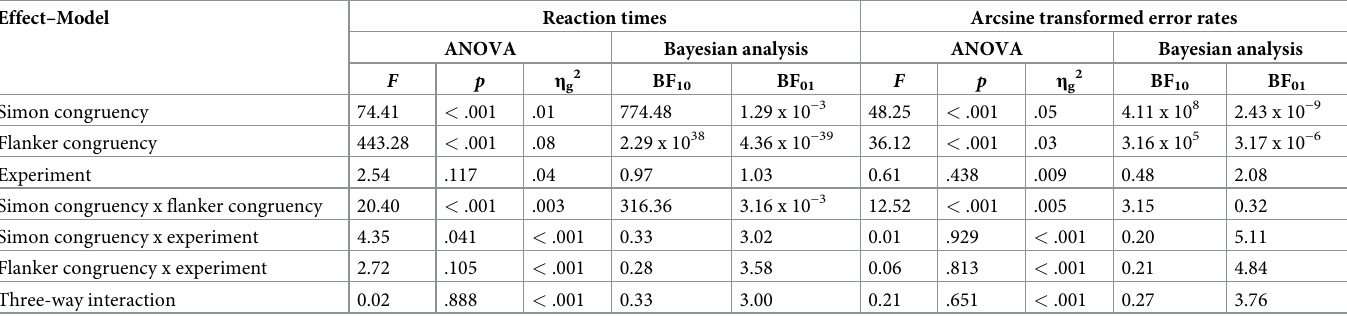
Table 6. Experiment 2 (Simon horizontal–flanker vertical) vs. Experiment 3: Inferential statistical values for the three-way analysis of variance (ANOVA) with Simon congruency (incongruent, congruent) and flanker congruency (incongruent, congruent) as within-subject variables, and experiment (Experiment 2, Experi- ment 3) as a between-subjects variable, and Bayes Factors (BF) from model